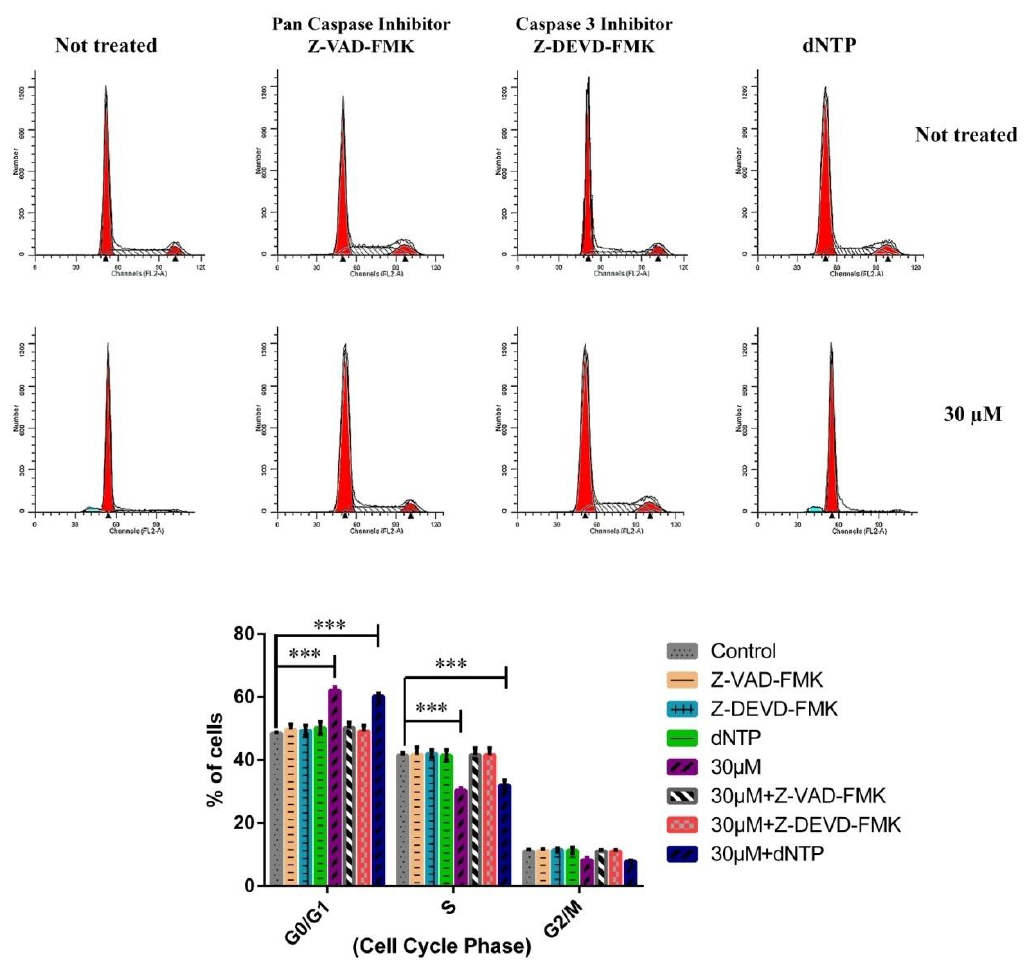
Figure 4. The effects of a caspase 3 inhibitor, a pan caspase inhibitor and nucleoside on compound 7 - induced cell cycle arrest in MCF-7 cells. *** p < 0.001 versus the control